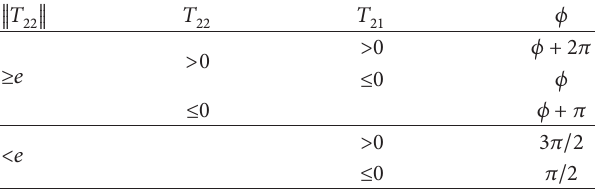
Table 2: The head angles of body.